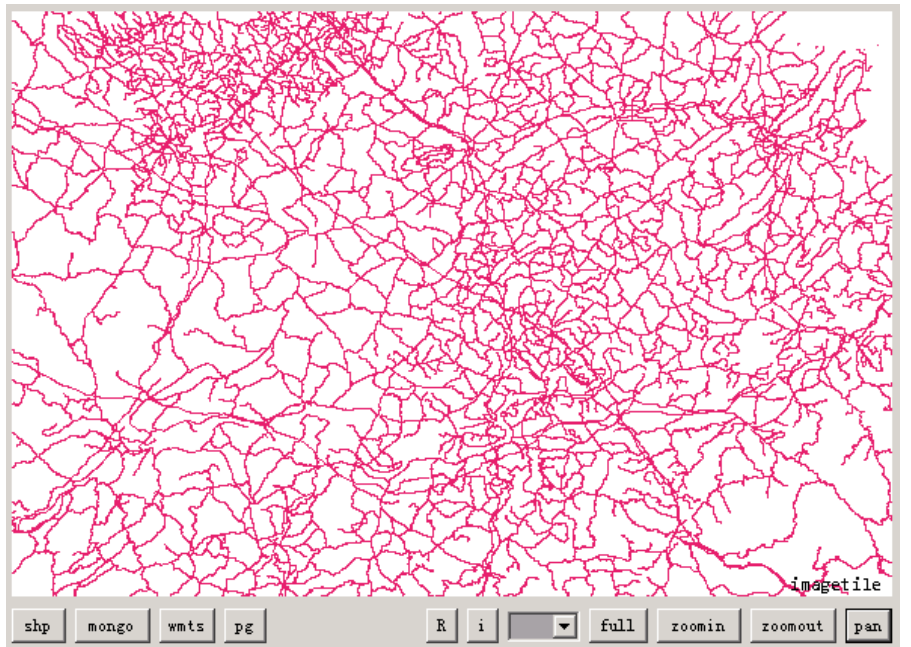
Figure 5. GIS engine sample program. This example embeds the GIS engine in a desktop application to quickly display the province’s water system data in the data cluster, allowing roaming, scaling, and query operations. We can also overlay other data sources, such as mongodb, shapefile, and map service. Layers are composed of subclasses driven by di ff erent data sources, including but not limited to